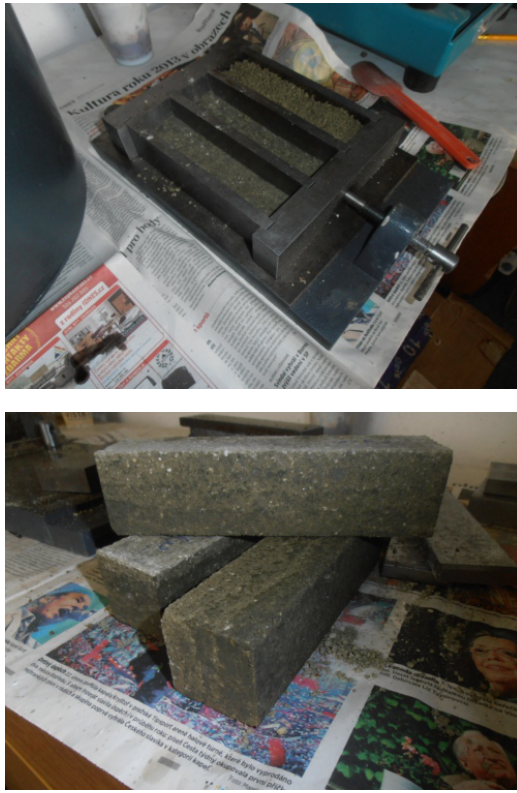
Figure 2. The production of rammed earth specimens.